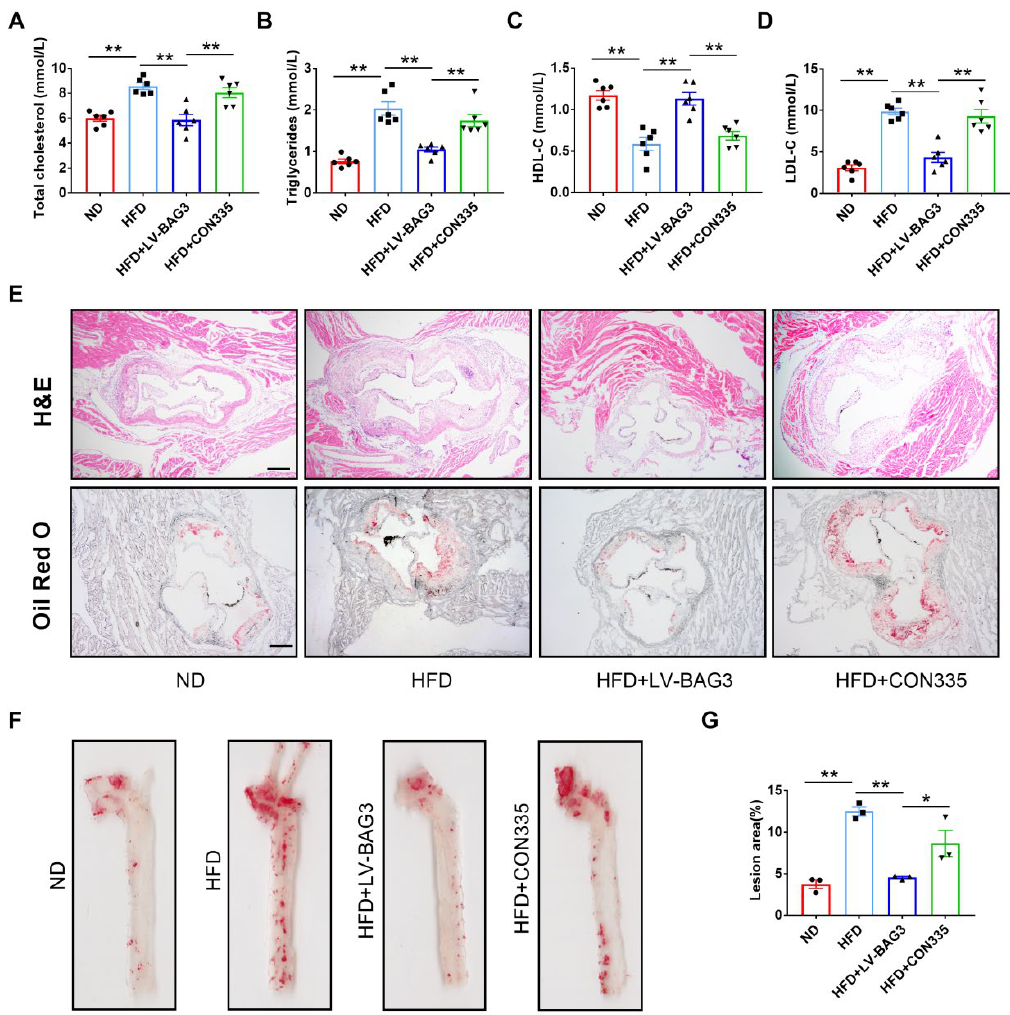
Figure 1. Overexpression of BAG3 reduces atherosclerotic lesions in ApoE − / − mice. ( A – D ) The levels of serum TG, TC, HDL-C and LDL-C in mice ( n = 6). ( E ) Hematoxylin–eosin (H&E) and Oil Red O staining of aortic root sections showing the atherosclerotic lesions and lipid deposition (scale bar indicates 200 µ m) ( n = 3). ( F , G ) Representative en face images of Oil Red O staining of aortas; the lesion area of the whole aorta was quantified ( n = 3). The data are presented as the mean ± S.E.M. * p < 0.05, ** p < 0.01.